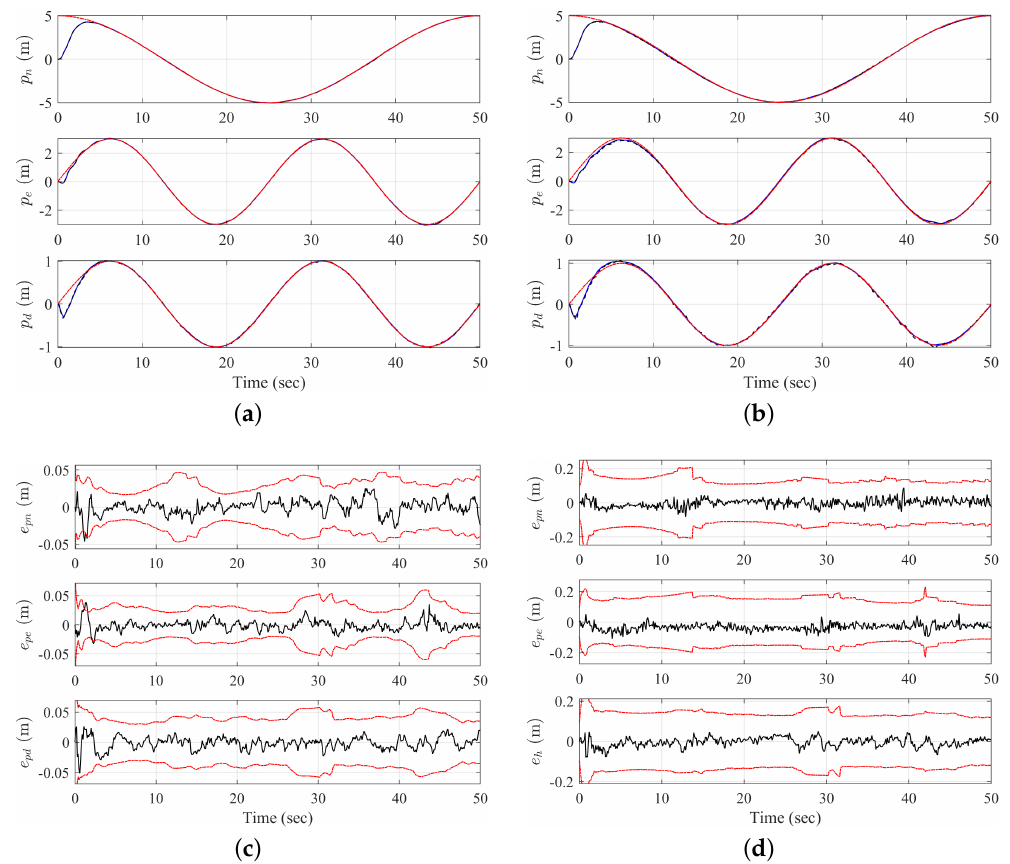
Figure 8. Quadcopter’s estimated position and corresponding estimation error when following an 8-shape trajectory for different cases. For ( a ) position for known landmarks and ( b ) posi- tion for unknown landmarks, true states ( ), estimated states ( ), and desired states ( ). For ( c ) estimated position error for known landmarks and ( d ) estimated position error for unknown landmarks, estimation error ( ), and 3 σ boundary (